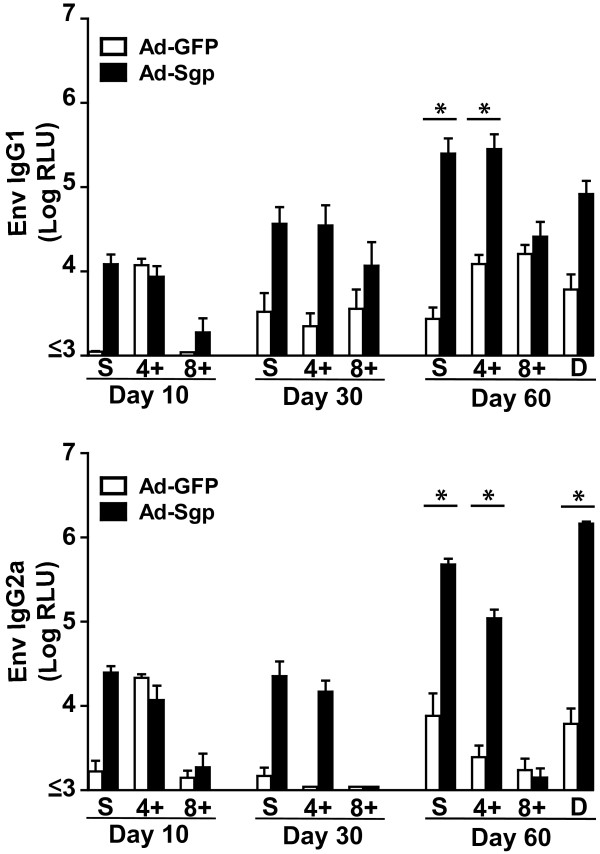
IgG1 and IgG2a antibody levels to SIVgp130 after cell transfer and subsequent VLP immunization. Donor mice (D) were immunized with adenoviral vectors encoding SIV GagPol or GFP. Six weeks later splenocytes (S), CD8-depleted splenocytes (4+), and CD4-depleted splenocytes (8+) were transferred into syngeneic recipient mice. The recipient mice and remaining donor mice were immunized with SIV VLPs 5 and 55 days after cell transfer. Mean and standard errors of IgG1 and IgG2a antibody levels to SIVgp130 of four animals per group are shown at the indicated days after the first VLP immunization. Statistically significant differences between the Ad-GFP and the Ad-Sgp group are marked by asterisks (p < 0.05, Mann Whitney test).